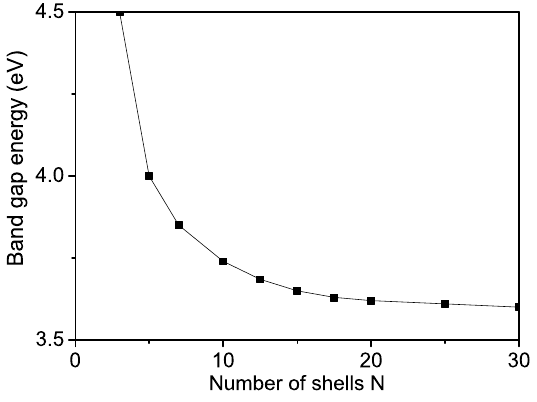
Figure 8. Size dependence of the band gap energy E g of a ZnS NP for T = 300 K. By doping of ZnS NPs with ions which radius is larger than that of the Zn ion, for example Y 3 + ( r = 1.04 ˙ A ), we obtain that E g increases. The result is shown in Figure 9, curve 3, in agreement with [66]. Within our model we observe also an enhanced E g with increasing Mn 2 + doping ions where the Mn ionic radius (0.83 ˙ A ) [30] is larger than that of the Zn 2 + ion (0.74 ˙ A ) (see Figure 9, curve 4) in accordance with [67] but in disagreement with [23,30]. We would observe eventually a decrease of E g taking a strong s-d interaction.